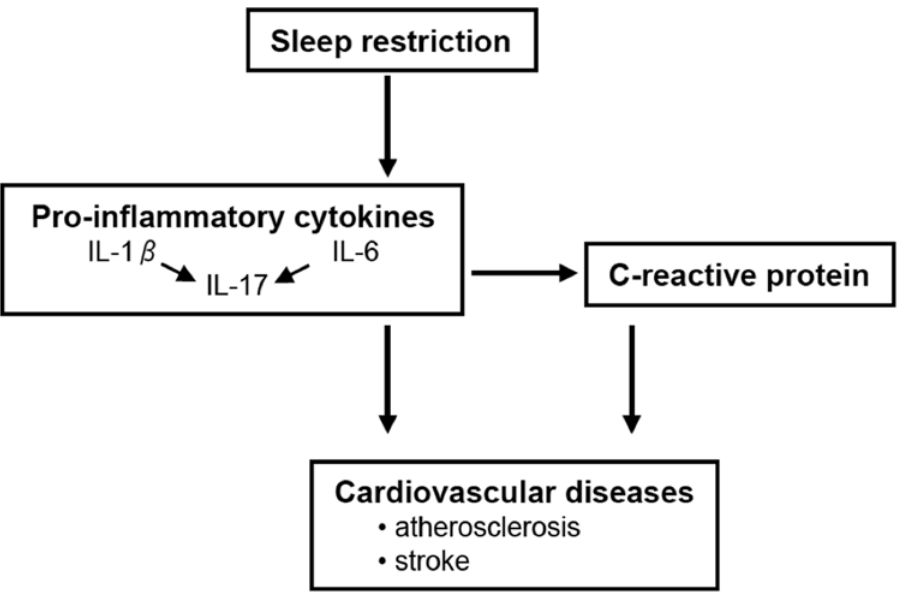
Figure 4. From sleep restriction to cardiovascular diseases. Schematic flow chart showing the proposed mechanism explaining how sleep restriction may ultimately evoke increased cardiovascular